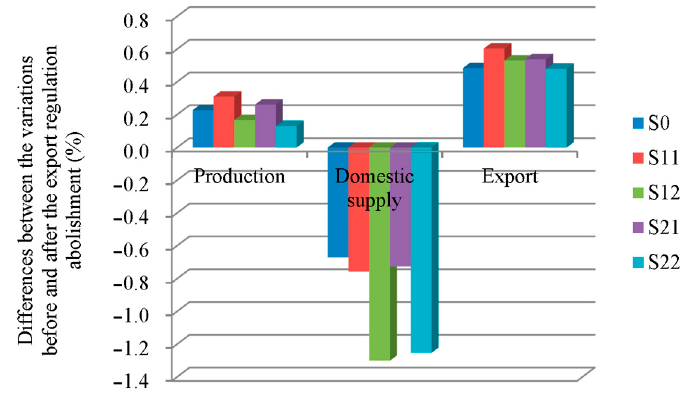
Figure 5. Differences among the variations in production, domestic supply and exports before and after the abolition of export regulations (%).